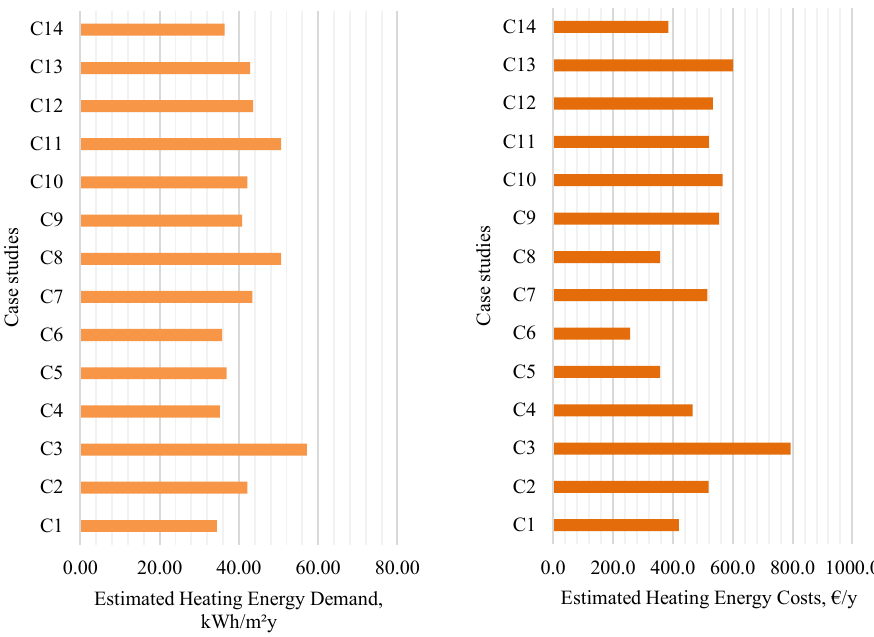
Fig. 4. Annual heating demand variation and annual heating cost variation for Bilbao case